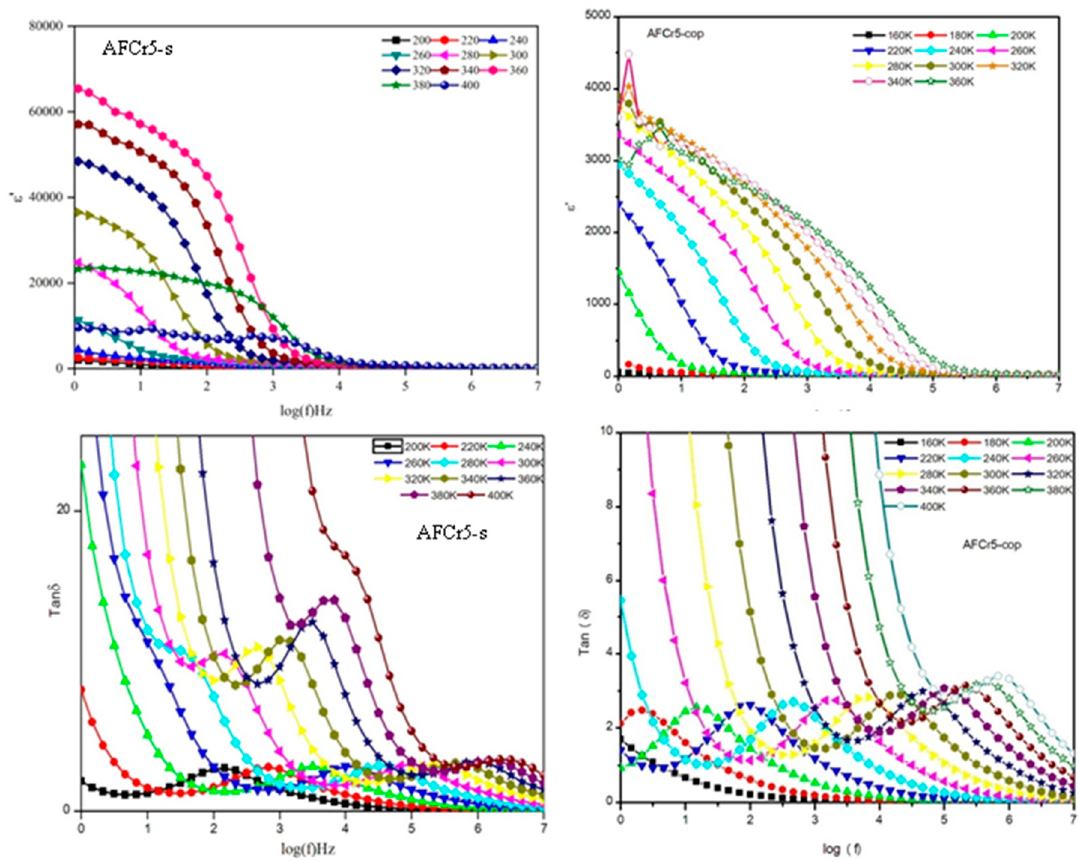
Figure 4. Evolutionof ε Figure 4. Evolution of ε ’ and loss tangent with frequency at different temperature in AFCr5-s and AFCr5-cop.